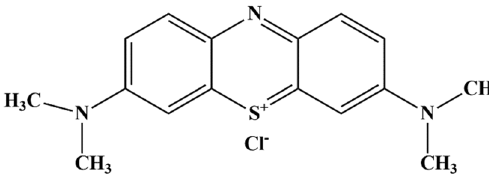
Fig. 1 Structural formula of methylene